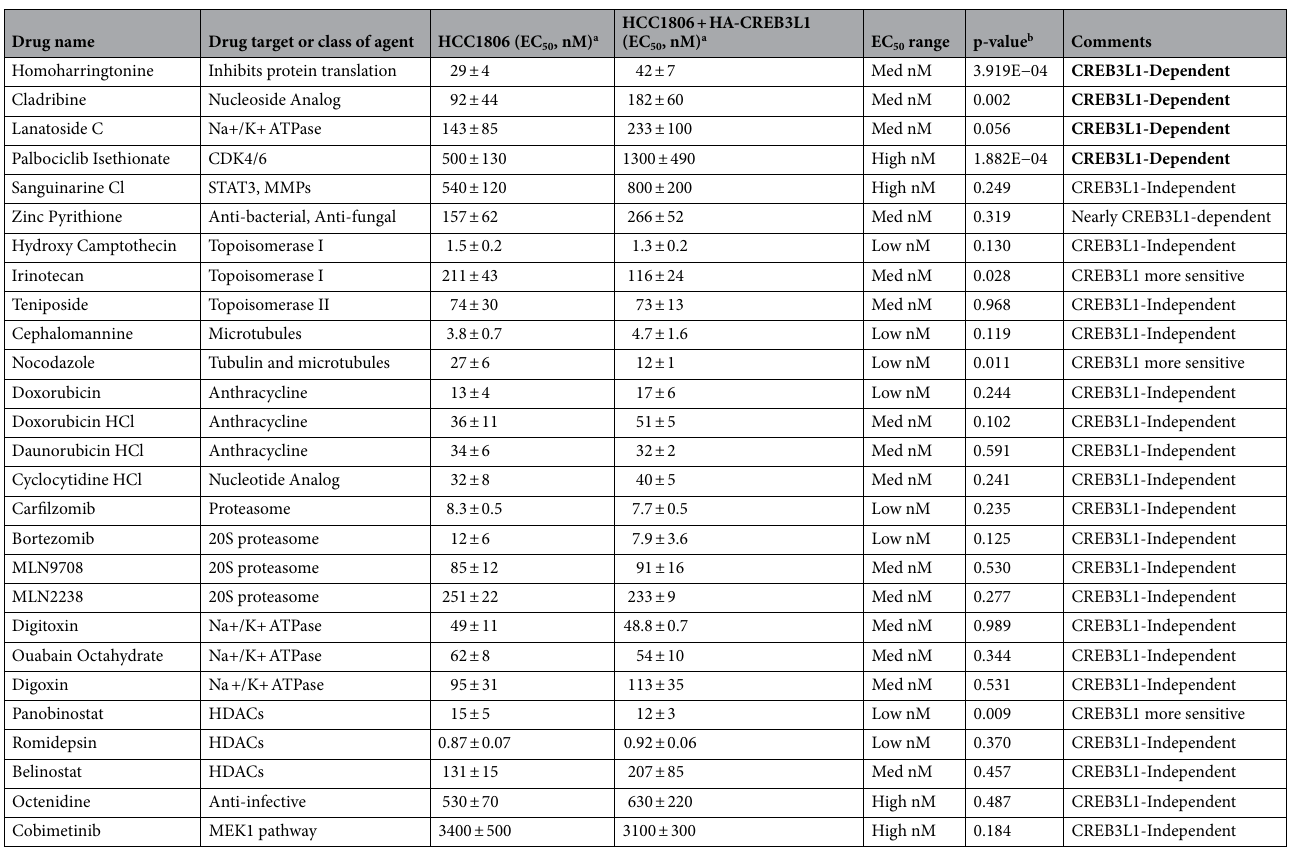
Table 1. EC 50 values for CREB3L1-deficient HCC1806 cells, as compared to HCC1806 + HA-CREB3L1 cells. Drugs with CREB3L1-dependent effects are in bold. a Mean ± SD from at least 3 replicate measurements. b p-value; student t-test for significance, HCC1806 + HA-CREB3L1 as compared to